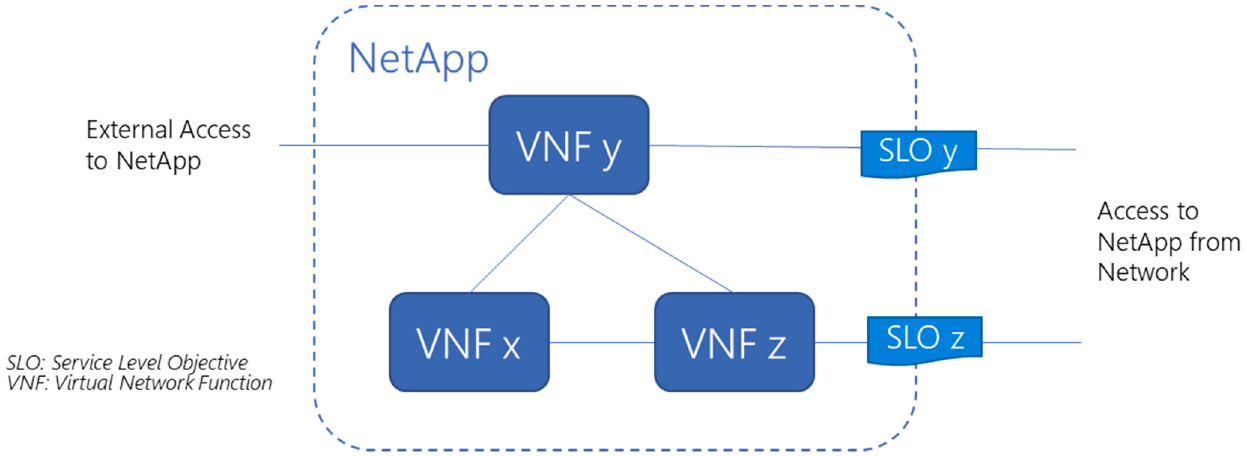
Figure 1. Basic NetApp representation.